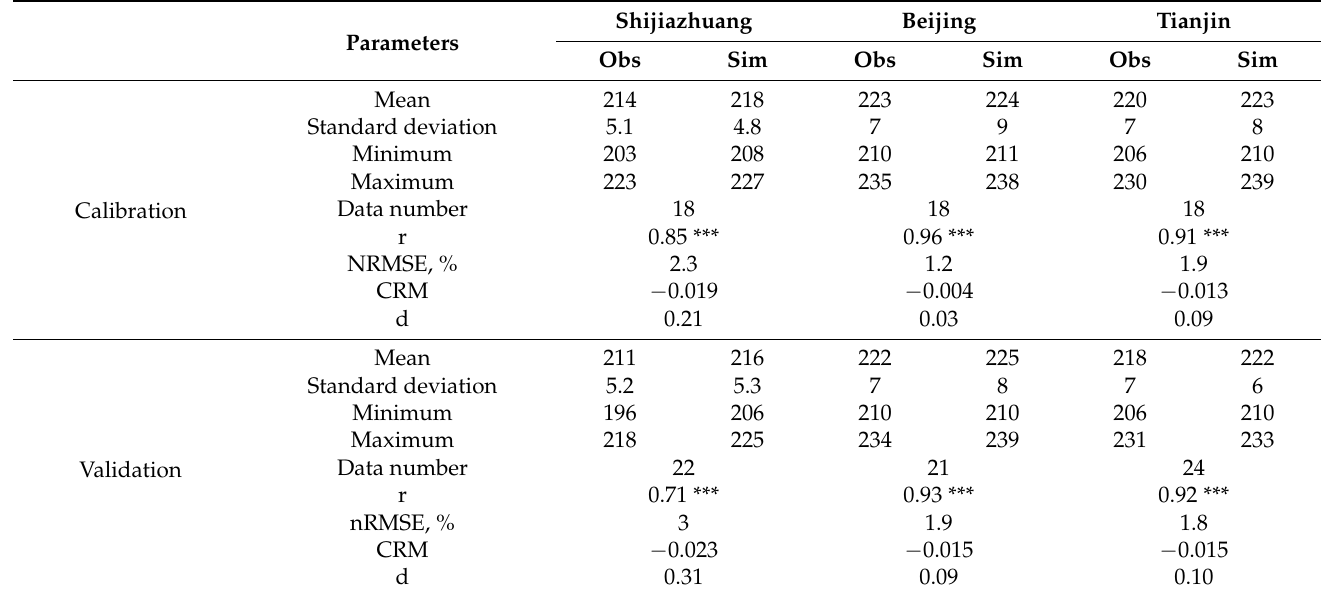
Table 4. Calibration and validation results of the DSSAT model for anthesis dates.